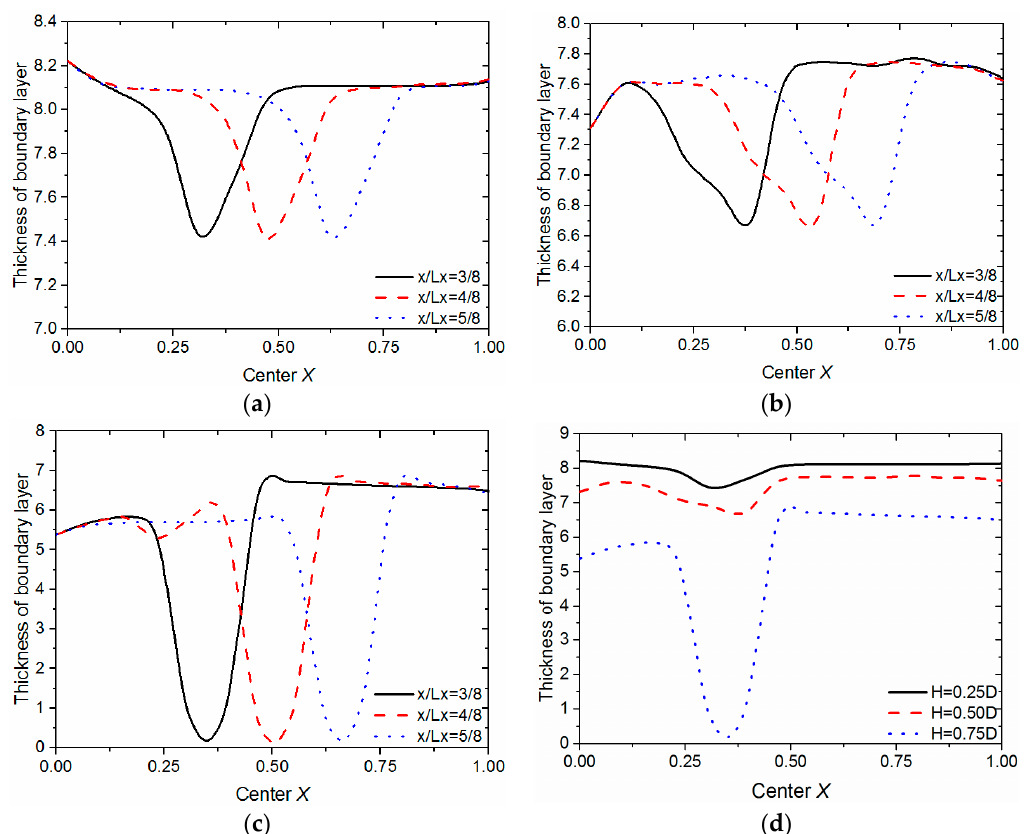
Figure 9. Changes of the thickness of the boundary layer in different locations (x/Lx = 3/8, 4/8, 5/8). ( a ) H = 0.25 D ; ( b ) H = 0.50 D ; ( c ) H = 0.75 D ; ( d ) x/Lx = 3/8.